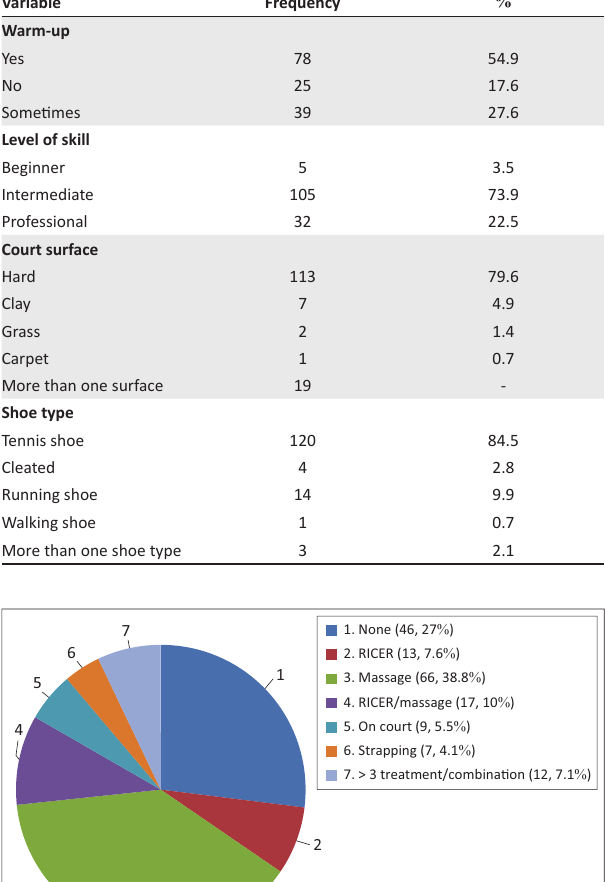
TAB LE 4: Level of skill, warm-up, court surface and shoe type ( n = 142).